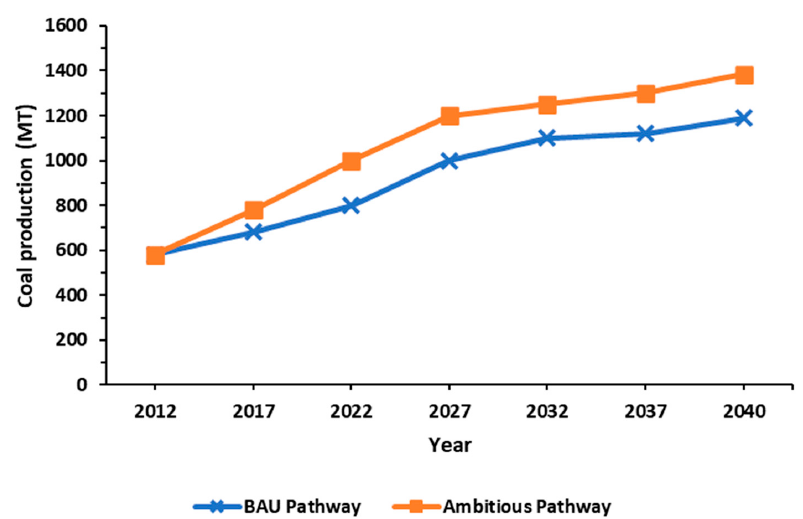
Figure2. Global growth in the demand of coal in an ambitious pathway and business-as-usual (BAU) pathway.